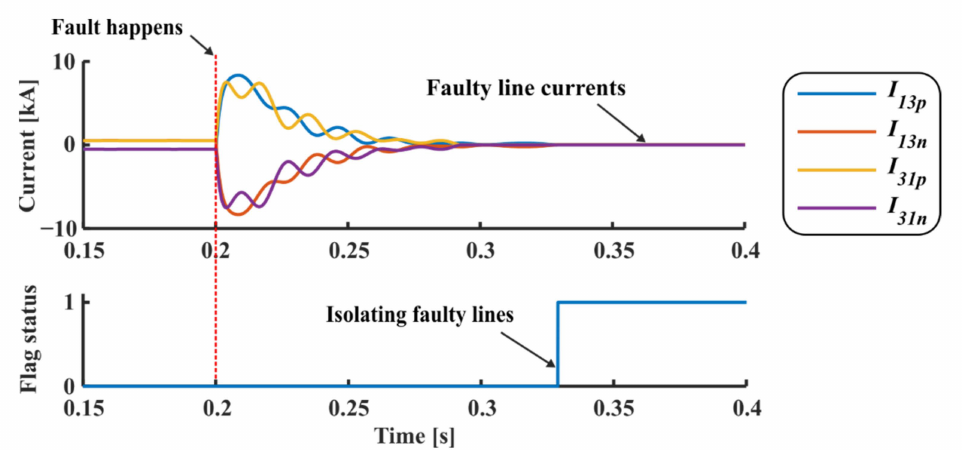
Figure 13. Fault currents and isolation status with DC fault at location F1.